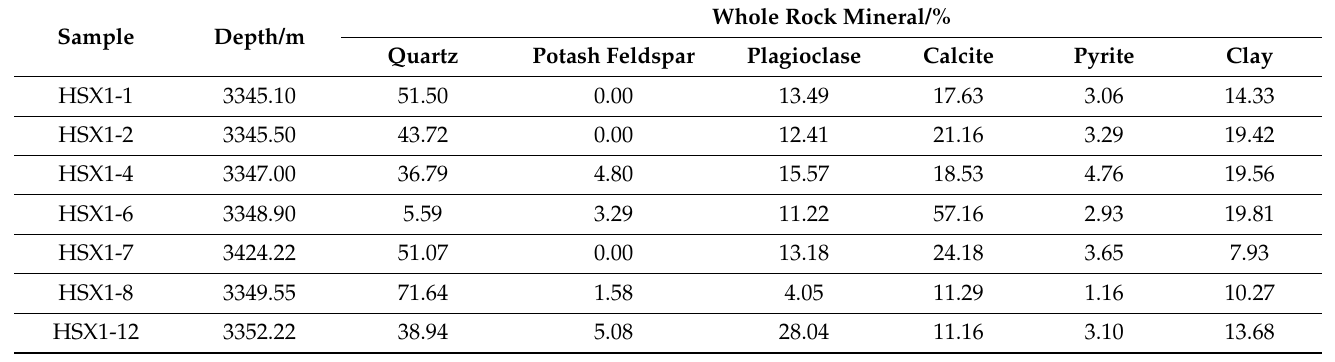
Table 1. Mineral compositions of shale samples.